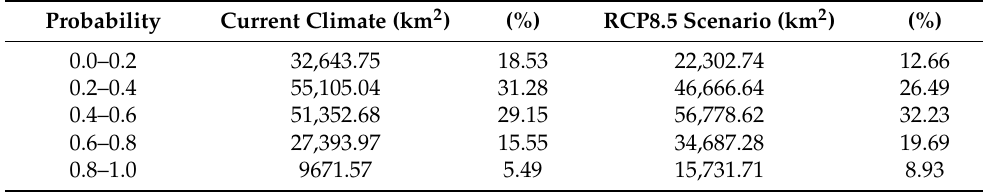
Figure 5. Potential probability under RCP8.5 scenario. Table 2. Probability statistics under current climate and RCP8.5